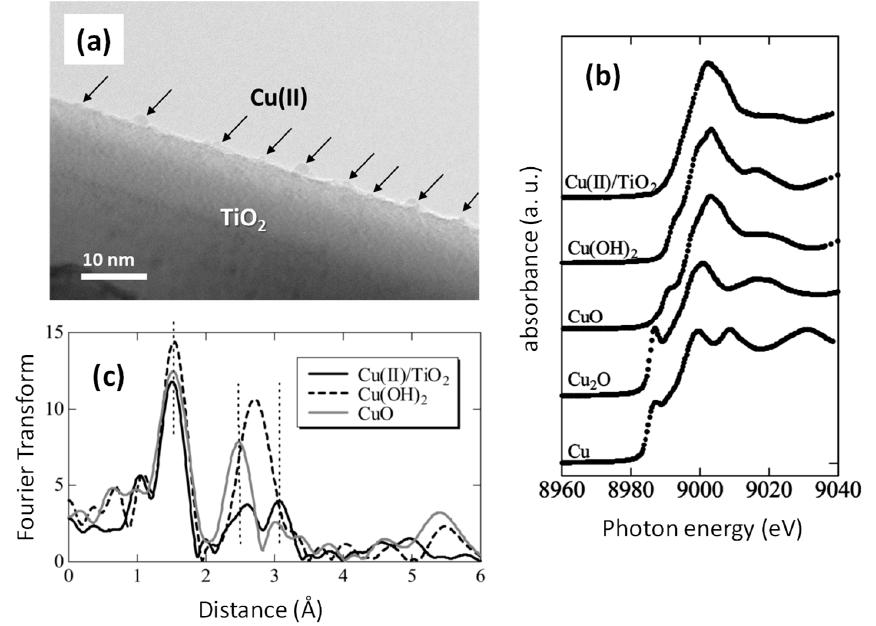
Figure 6. ( a ) TEM image, ( b ) XANES analyses, and ( c ) Fourier transforms of EXAFS for Cu(II) / TiO 2 [27]. Commercial powder of Cu, Cu 2 O, CuO, and Cu(OH) 2 (Wako Ltd.) were used as references.